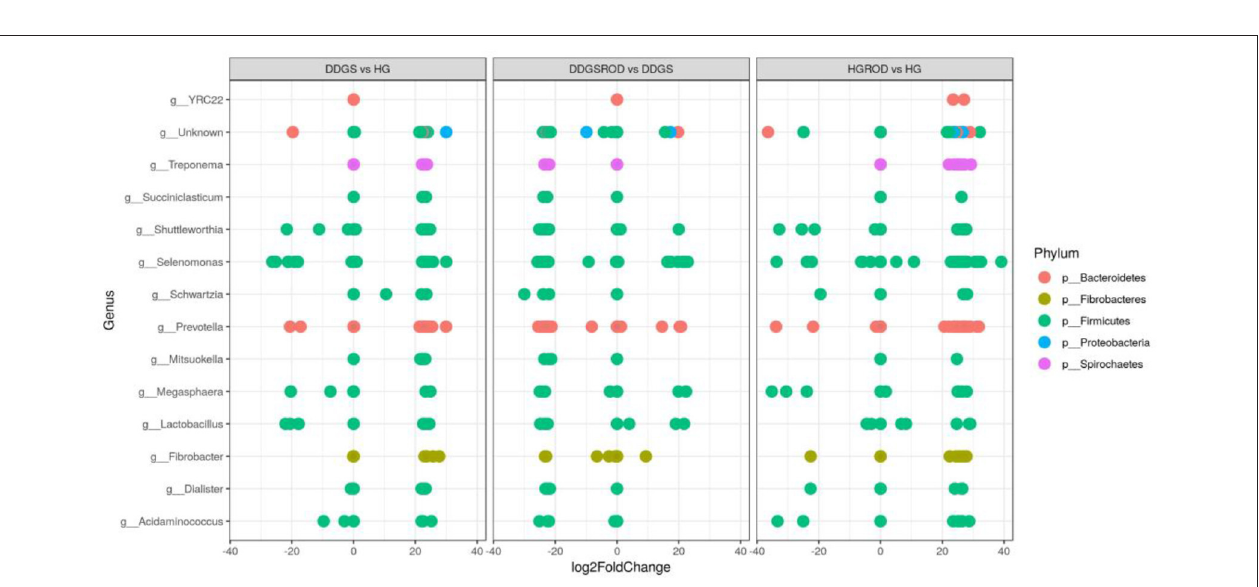
FIGURE 5 | Relative changes (log2 fold; P < 0.05) of ruminal bacteria by DDGS vs. HG, DDGS&ROD vs. DDGS, and HG&ROD vs. HG at the genus level. DDGSDDGS diet without adding the ROD extract; DDGS&ROD (wheat DDGS diet with ROD extract); HG (basal diet without adding the ROD extract); HG&ROD (basal diet with the ROD